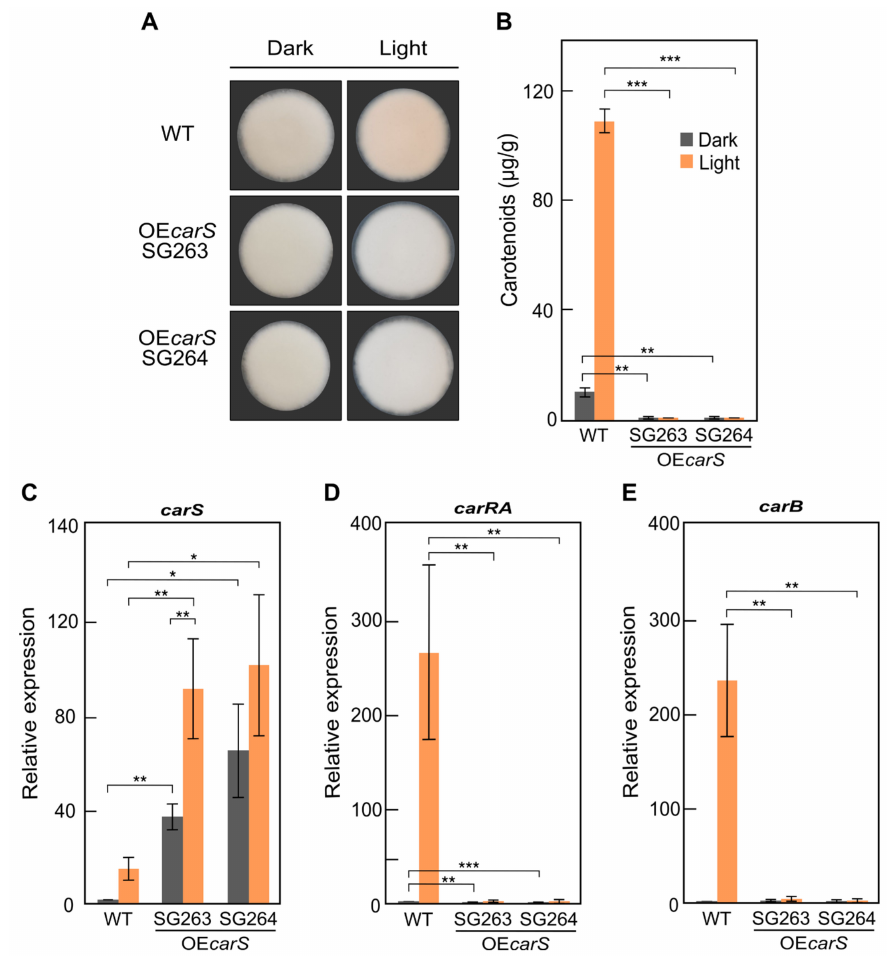
Figure 7. Effect of constitutive expression of the carS gene in F. fujikuroi: ( A ) Phenotypes of two OE carS transformants (SG263 and SG264) and the wild strain (WT) grown on DG agar medium for five days at 30 ◦ C in the dark or under light. ( B ) Carotenoid content in mycelia of WT and OE carS transformants grown for seven days in darkness or under light. Data are the average and standard deviation from three independent experiments. ( C – E ) Transcript levels of carS , carRA , and carB in WT and OE carS transformants; RNA was isolated from strains grown in darkness for three days and exposed to light for one hour or kept for this time in the dark. Data of qRT-PCR are the average and mean error of five independent experiments. Values were normalized to the WT samples in the dark. * p < 0.05; ** p < 0.01; *** p <